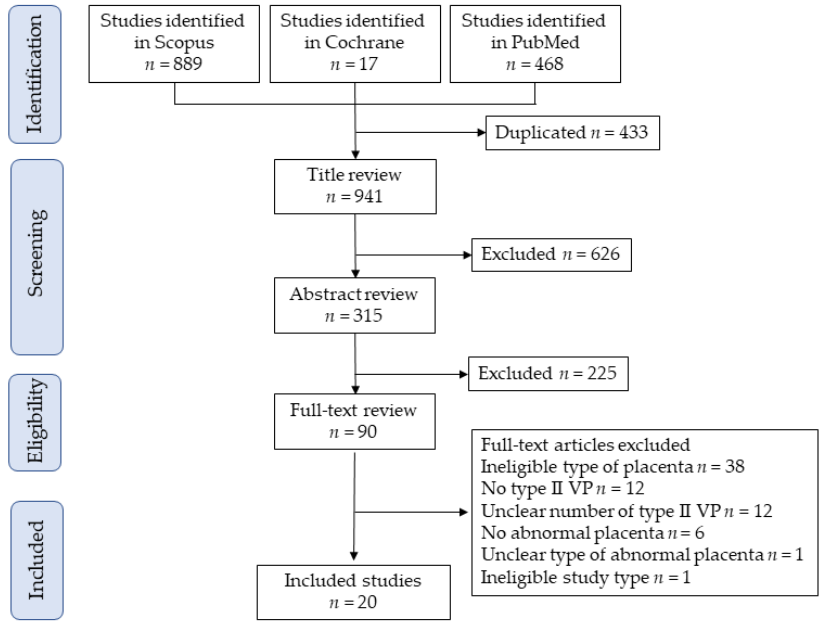
Figure 1. Study selection scheme of the systematic search of previous studies. Abbreviation: VP, vasa previa.